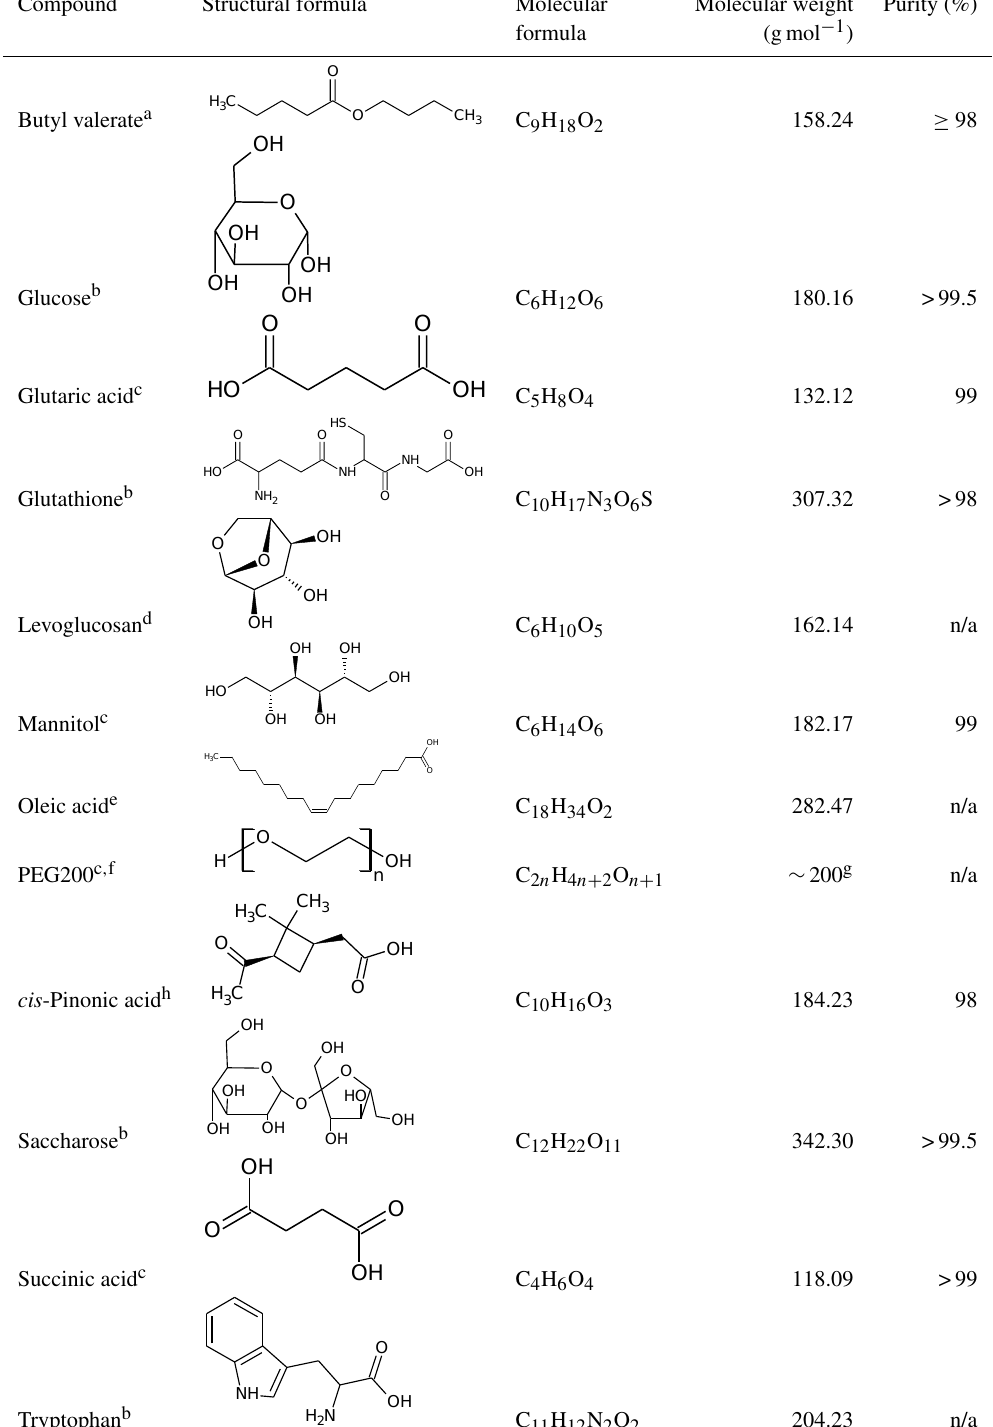
Compound Table 1. Organic substances investigated in the laboratory studies; n/a: not available. Compound Structural formula